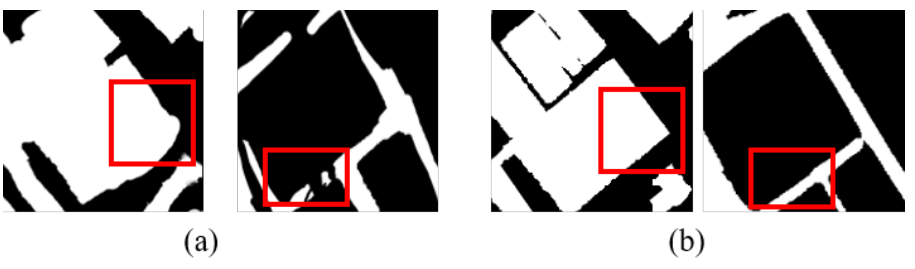
Figure 6. Comparing results between ( a ) the baseline method and ( b ) the baseline method plus RCM and Affinity loss. As shown in the red box, the results from the method with adding modules are better than the baseline method in terms of completeness and regularity of